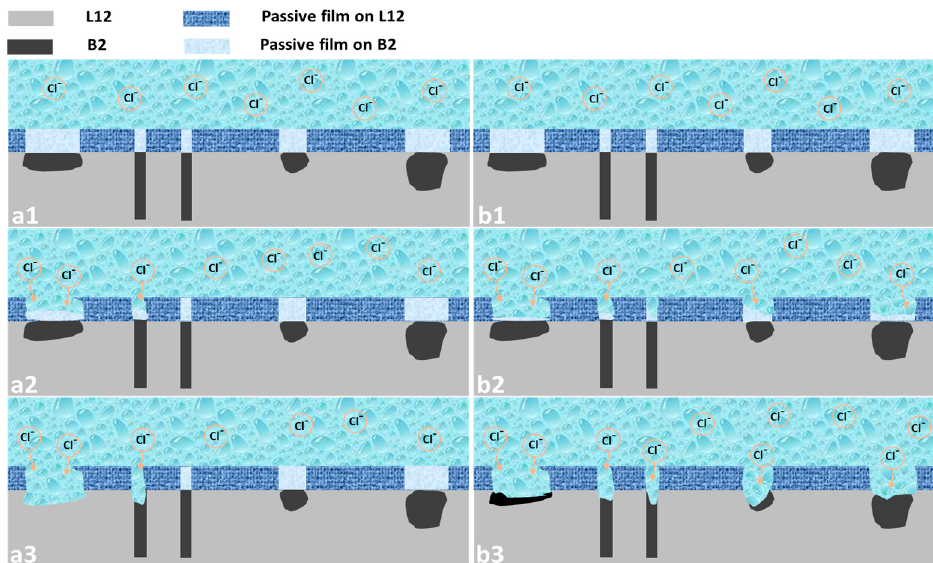
Figure 14. Schematic diagram of corrosion on AlCoCrFeNi 2.1 in chloride-containing sulfuric acid solution at: ( a1 – a3 ) low temperature; ( b1 – b3 ) high temperature.